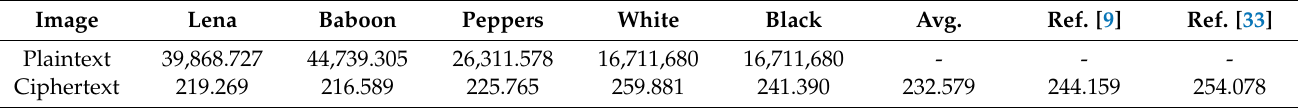
Table 1. χ 2 test (256 ∗ 256).